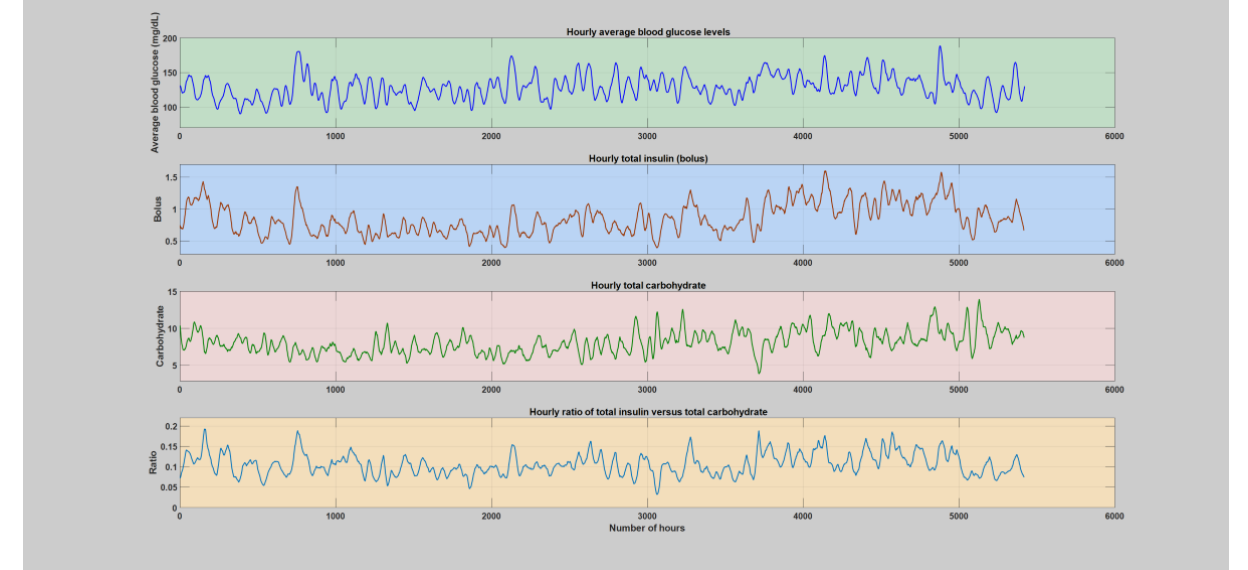
Figure 2. The first patient year, where there is no incidence of acute infections. The figure depicts variation of average blood glucose levels, total insulin (bolus), total carbohydrate, and total insulin-to-carbohydrate ratio during each hours of the day. The operating point of the